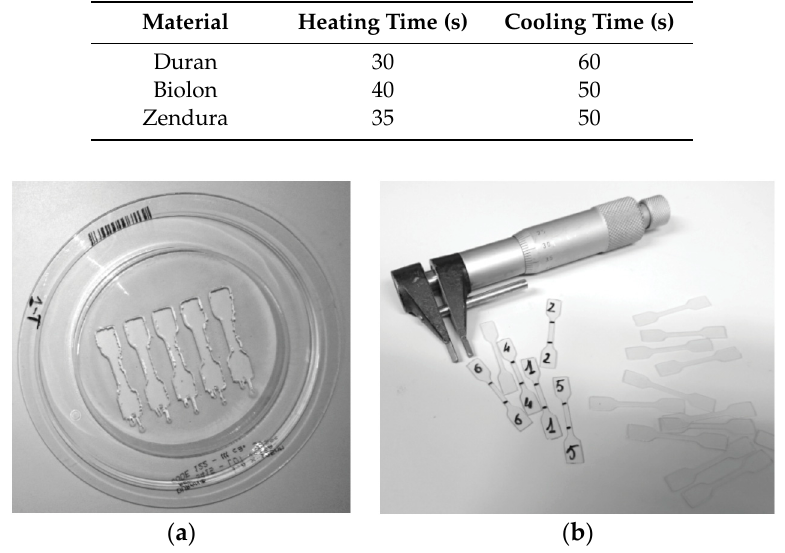
Figure 1. Thermoformed material after waterjet cutting ( a ) and resulting specimens ( b ).